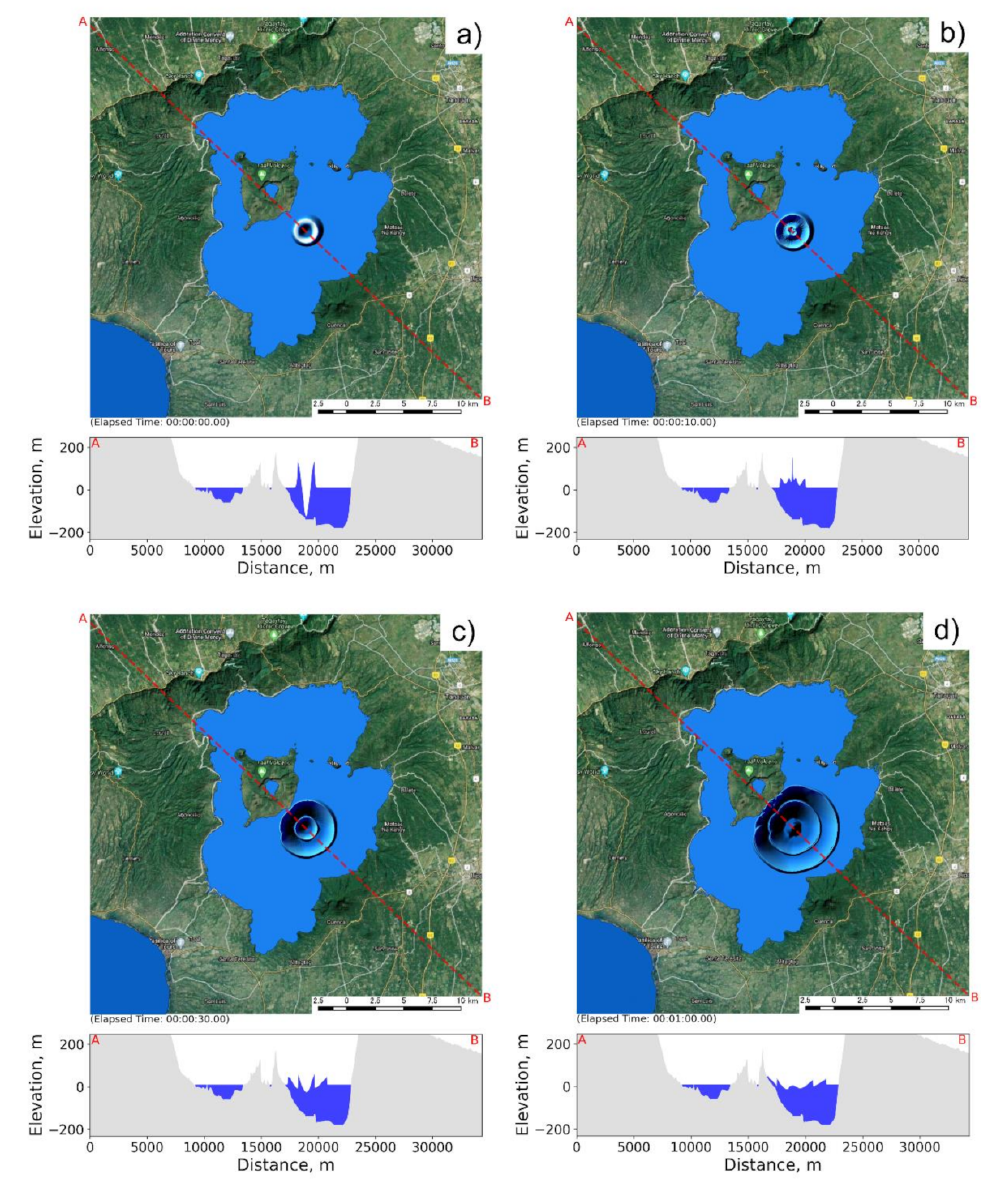
Figure 4. Tsunami generation: ( a ) 0 s, ( b ) 10 s, ( c ) 30 s, and ( d ) 60 s. The inundation depth at each building point was determined for each building occu- pancy. Figure 6 shows the tsunami characteristics with the number of inundated buildings represented by the histogram for five examples of scenarios. There are 29,889 residential buildings in the coastal area of Taal Lake, and the analysis revealed that 13,548 buildings were impacted by the 99th scenario. In all scenarios, the highest number of inundated buildings corresponded to low inundation depths between 1 and 10 m. For example, the peak of the 1st scenario was at a water depth of approximately 1 m, while the peak of the 99th scenario was at a water depth of approximately 2